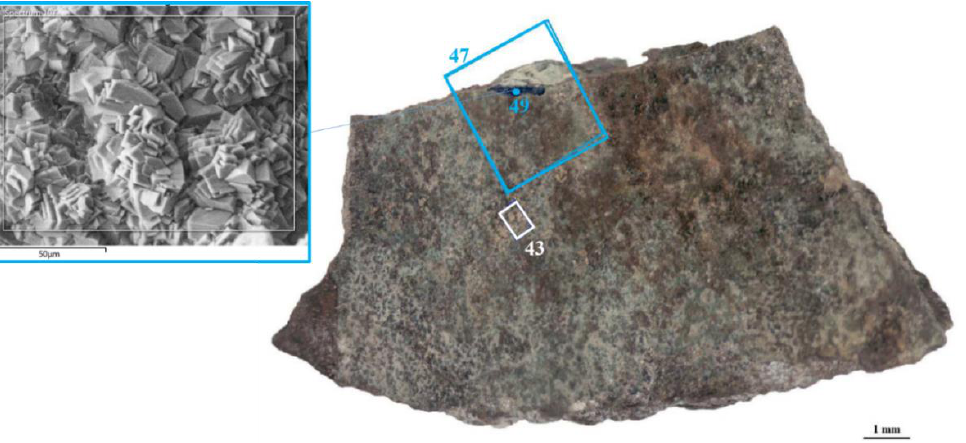
Figure 11. Schematic of the areas investigated by SEM-EDS for sample 16. The area 43, colored in white, presented a green patina from which a rust-colored area can be glimpsed. On the top, the azurite-rich area (area 47) and its detail (detail 49) was both colored light blue. SEM image is related to detail 49 (in light blue).